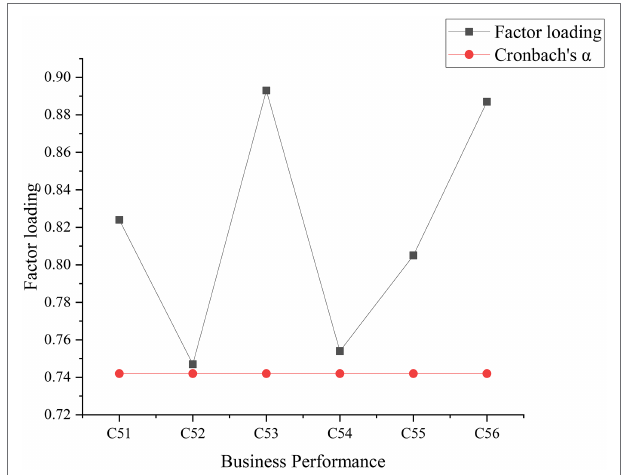
FIGURE 8 | Reliability and factor analysis of enterprise performance variables.